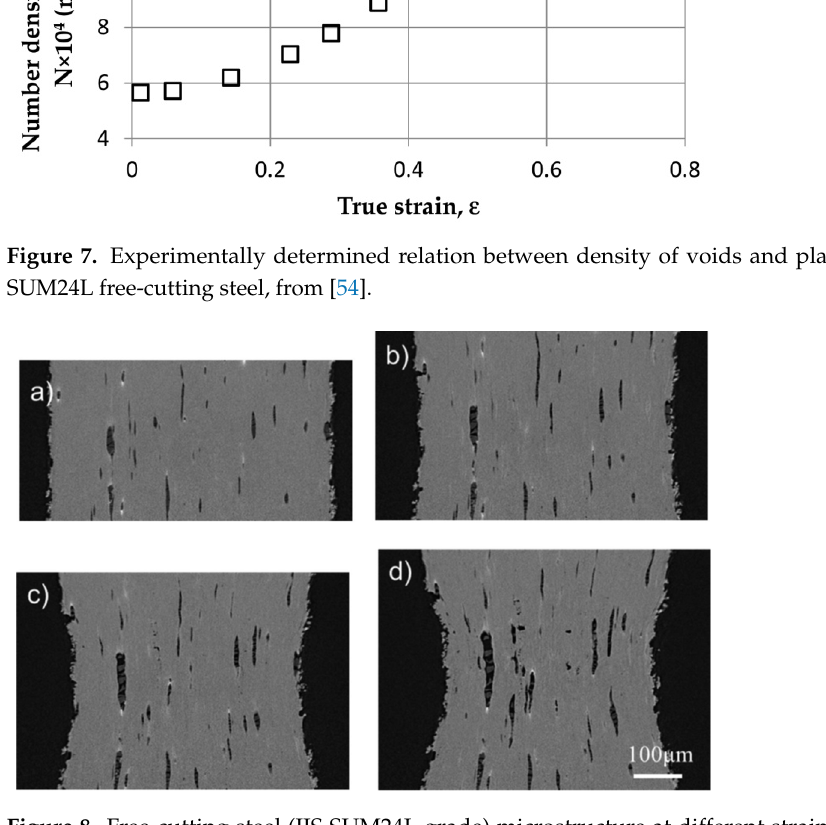
Figure 8. Free ‐ cutting steel (JIS SUM24L grade) microstructure at different strains: ( a ) 0; ( b ) 0.23; ( c ) 0.50; ( d ) 0.64, from [54]. ( c ) 0.50; ( d ) 0.64, from